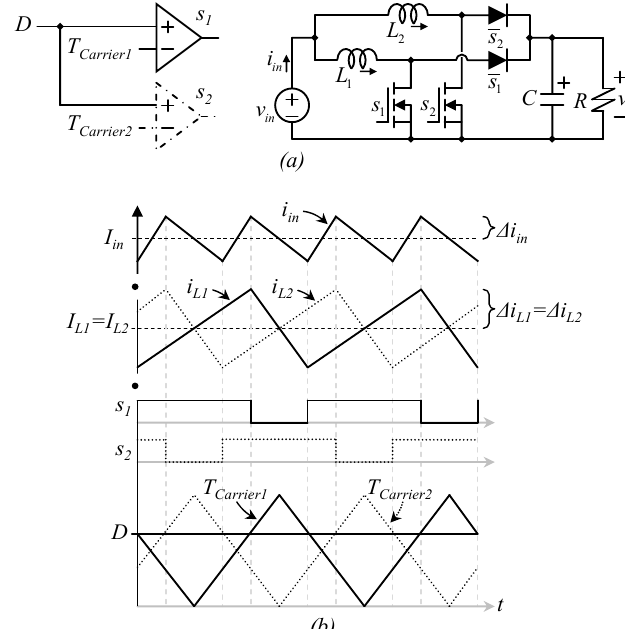
Figure 2. The (two phases) traditional interleaved boost converter ( a ) topology and PWM generation strategy, ( b ) important waveforms related to the input current ripple.